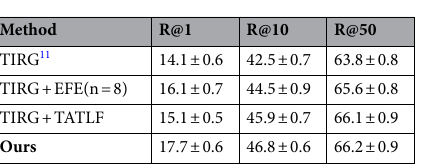
Table 3. Ablation studies of our method on Fashion200k dataset.